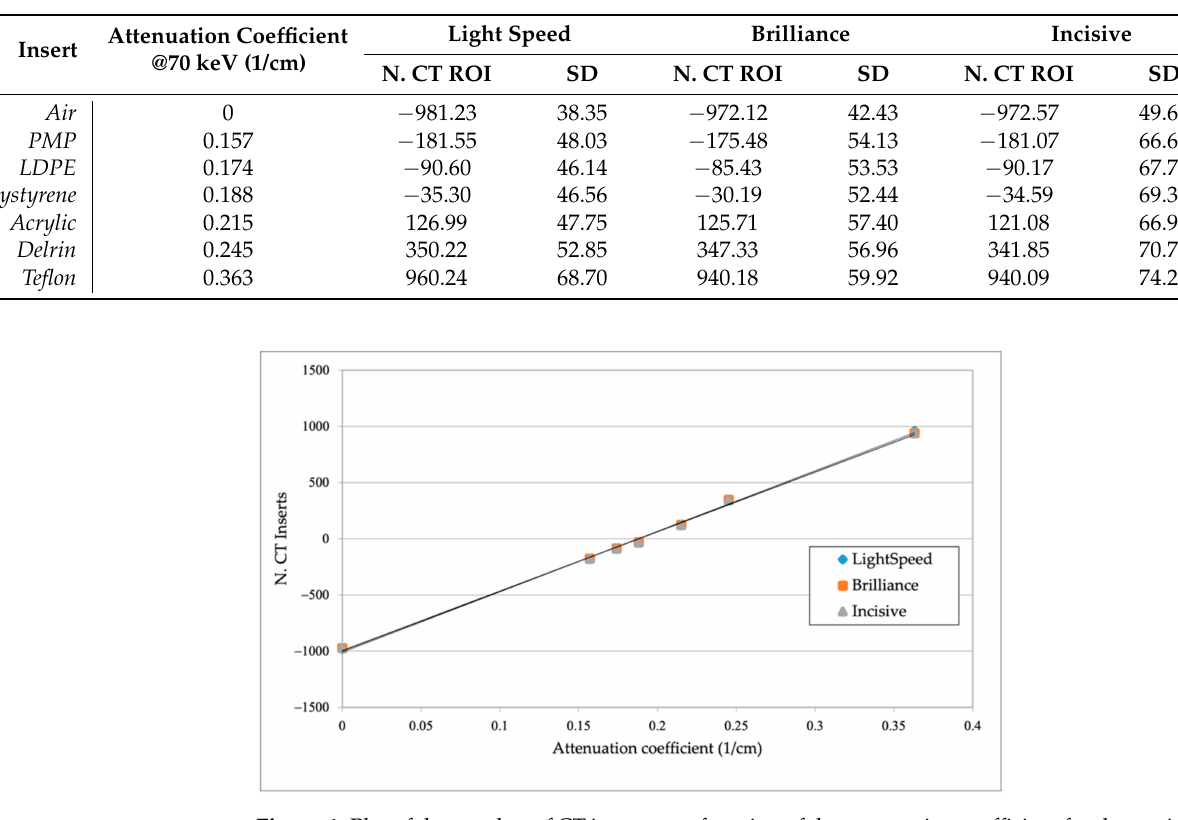
Figure 4. Plot of the number of CT inserts as a function of the attenuation coefficient for the equipment used. The trend line for each of the data sets is also